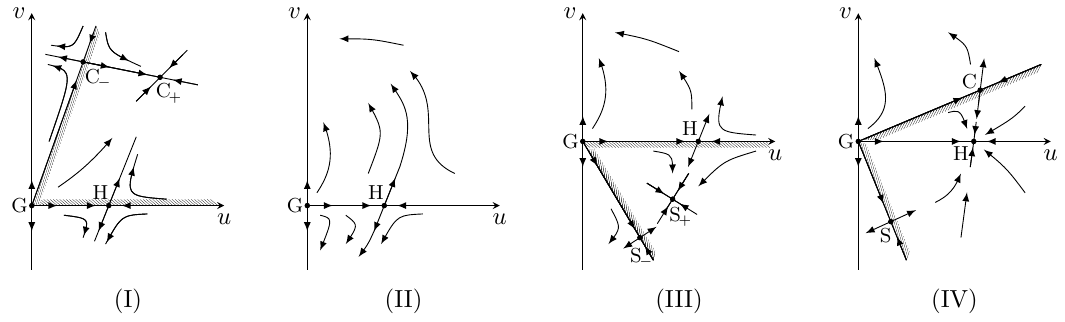
Figure 1: Flow diagrams corresponding to the various regimes mentioned in the text. The hatched regions represent the basins of attraction of the stable fixed point. This figure is a reproduction of [ 13, Fig. 7 ]